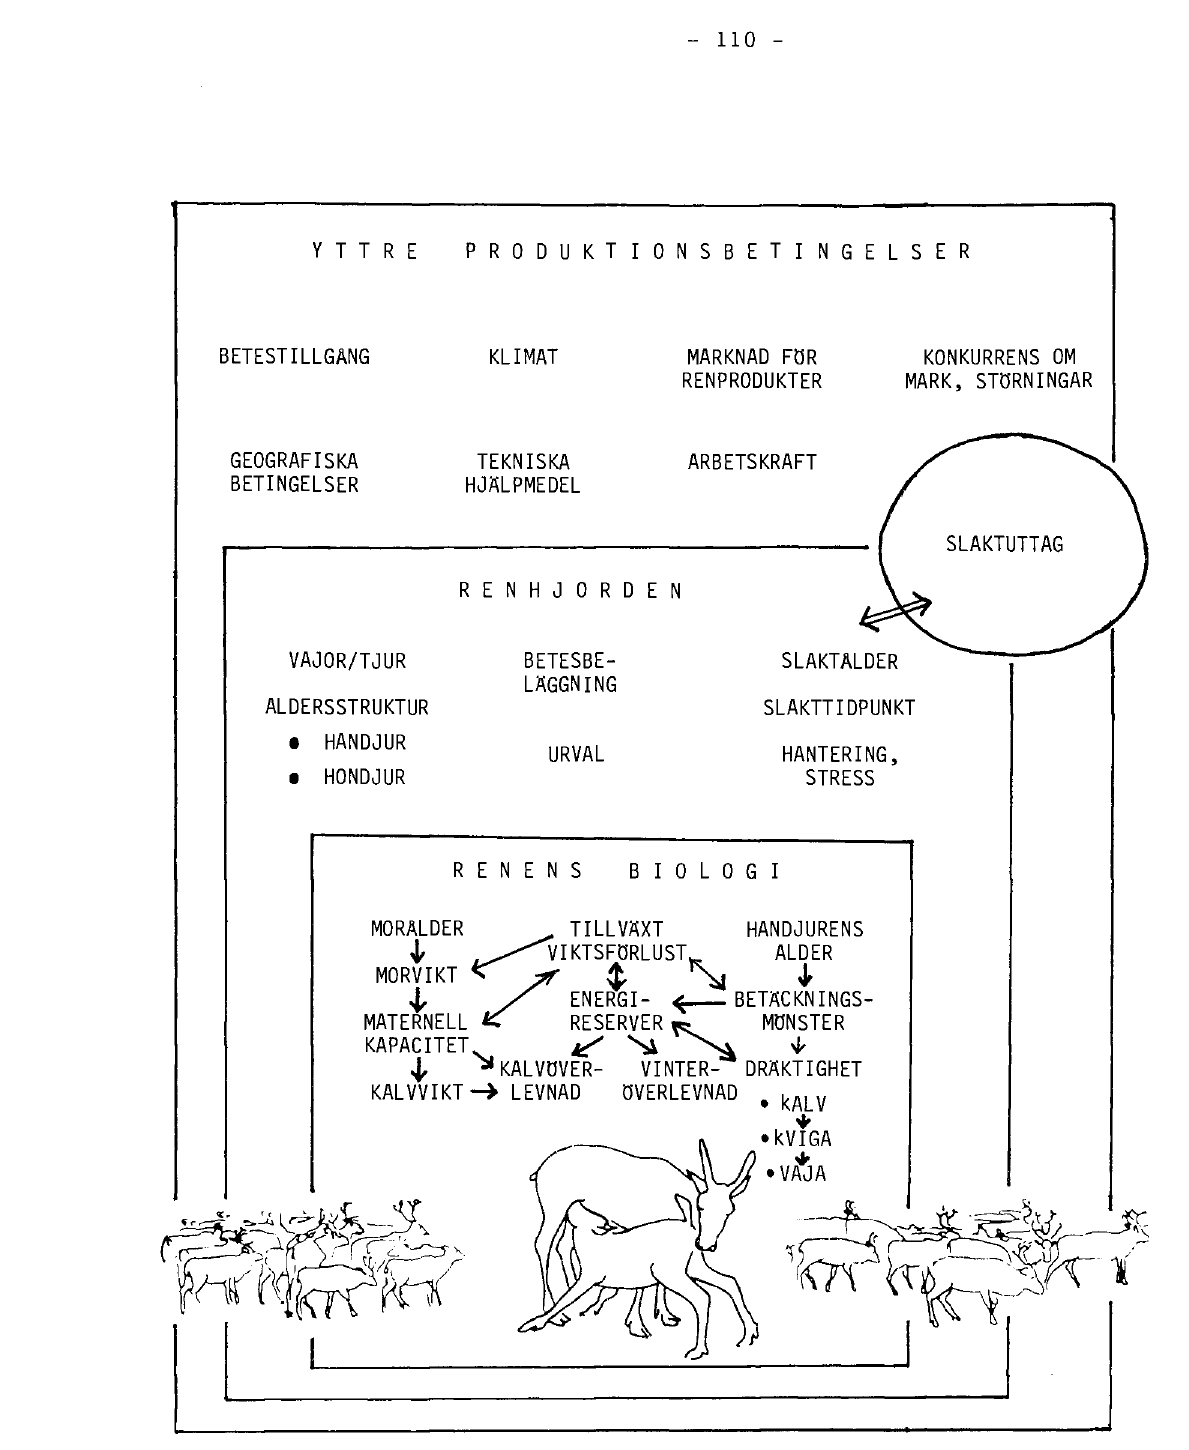
Figur 1. Faktorer som påverkar renhjordens